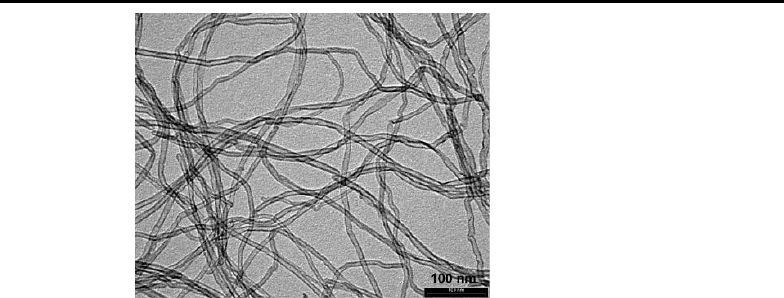
Table 2. Structure and specification of Nanocyl NC 7000 carbon nanotubes and of filter dust